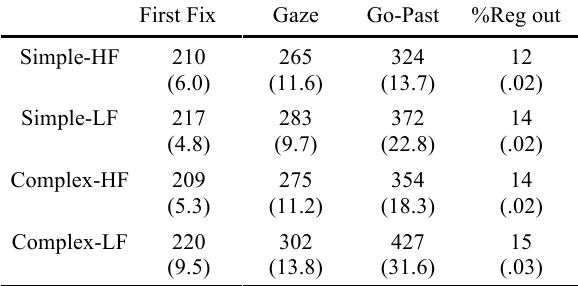
Average eye movement measures on Region 2, the critical adverb, in milliseconds (standard errors in parentheses).